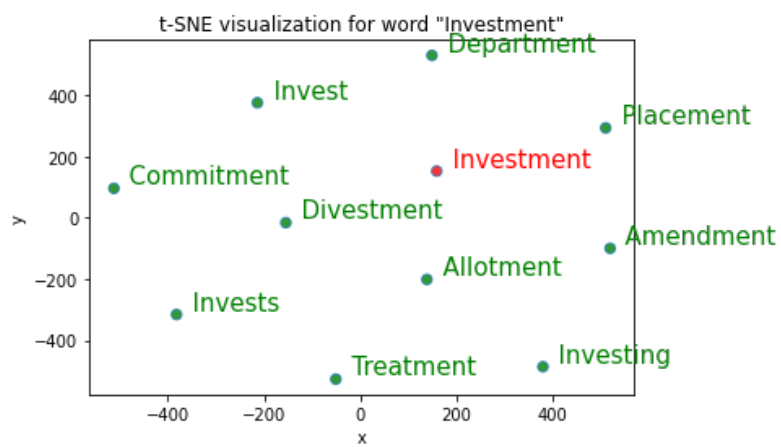
Figure 10. The t-SNE plot for the word capitalism.